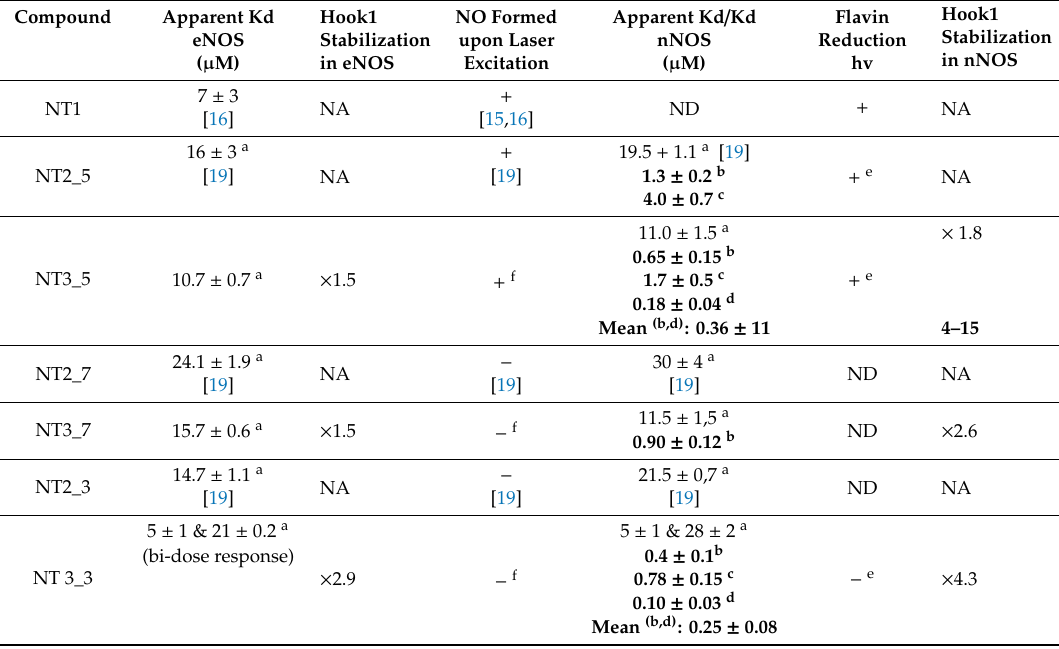
Table 1. Experimental Kd values obtained using the fluorescence changes of the NT compounds upon binding to eNOS or to nNOS (see Figure